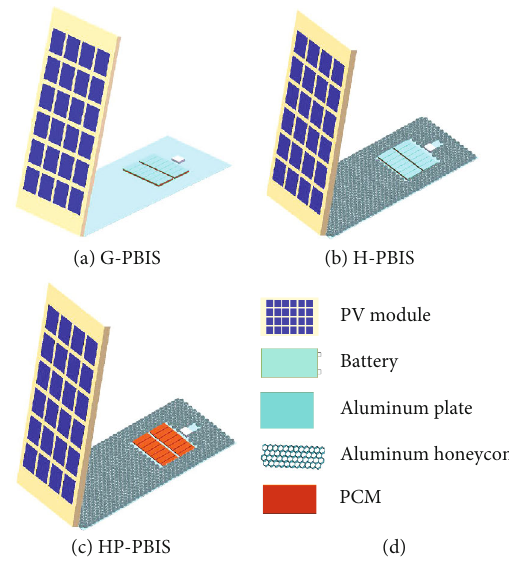
Figure 1: Geometric model designs of PBIS: (a) G – PBIS, (b) H – PBIS, (c) HP – PBIS and (d) Description of PBIS